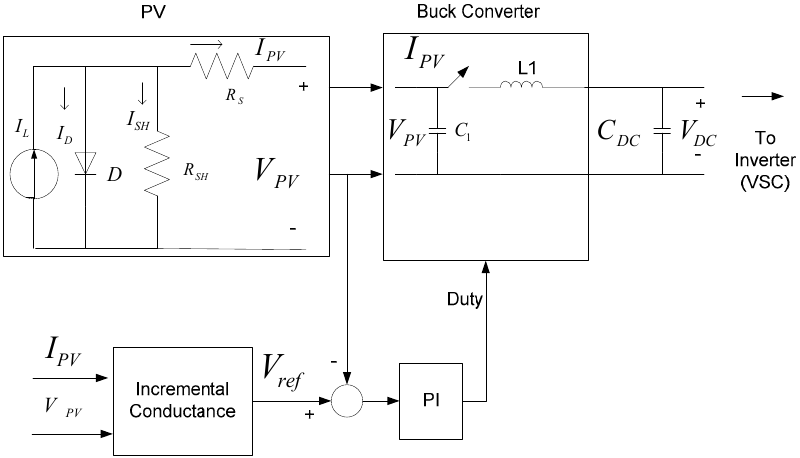
Figure 2. Maximum power point tracking (MPPT) and buck converter controller. Table 1. Photovoltaic (PV) panel, battery and other component parameters.